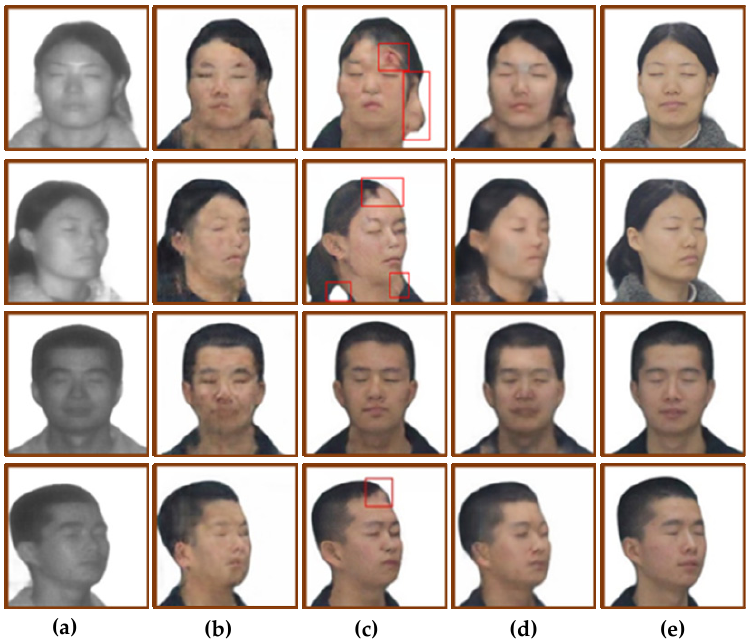
Figure 13. The translation results of changing the feature extraction module to RRDB. The red box shows the defects in the translated image of the first improved model. ( a ) Input laser image. ( b ) CycleGAN. ( c ) The first improved model. ( d ) Change to RRDB module. ( e ) Ground truth.